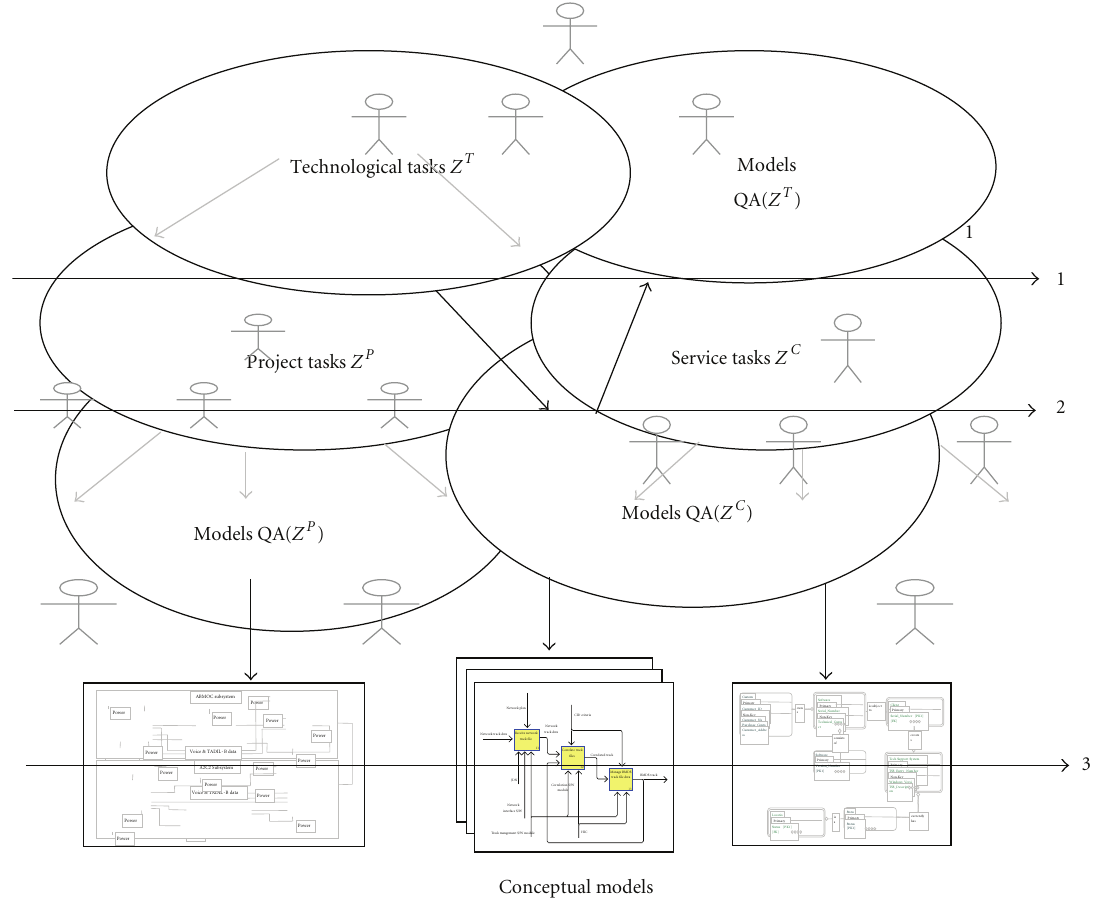
Figure 10: Relations between